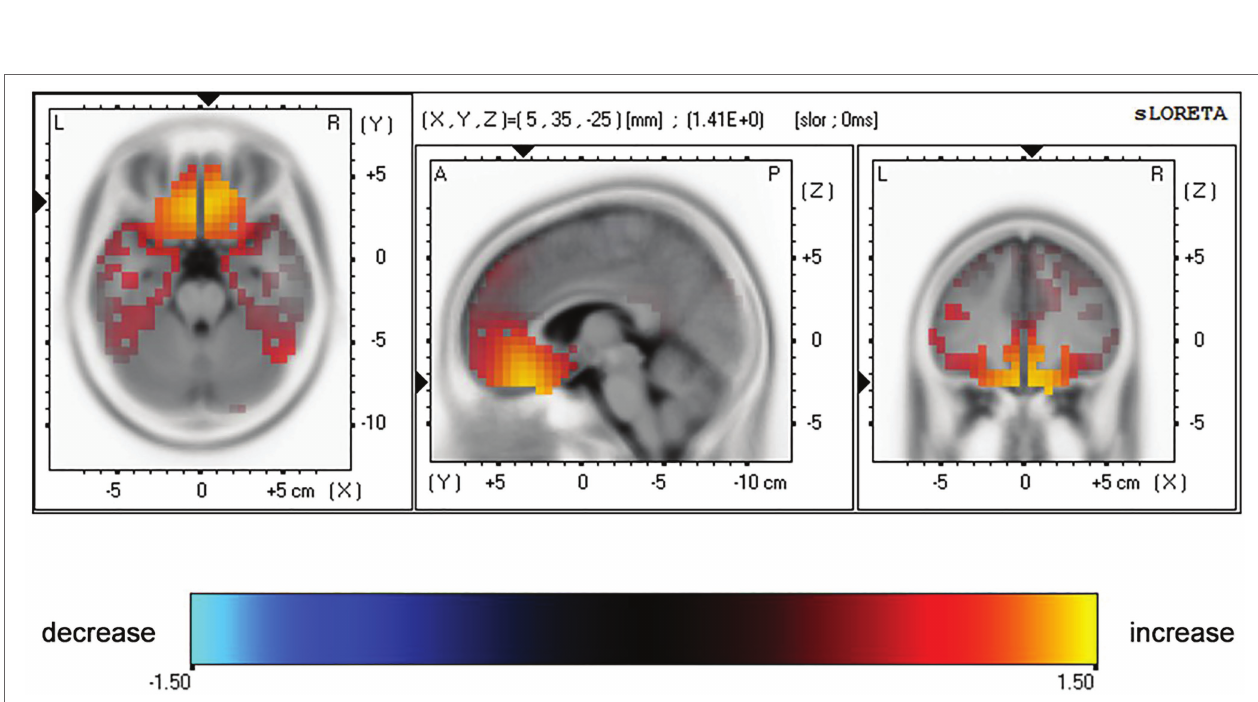
Close regions ( d < 5 mm)